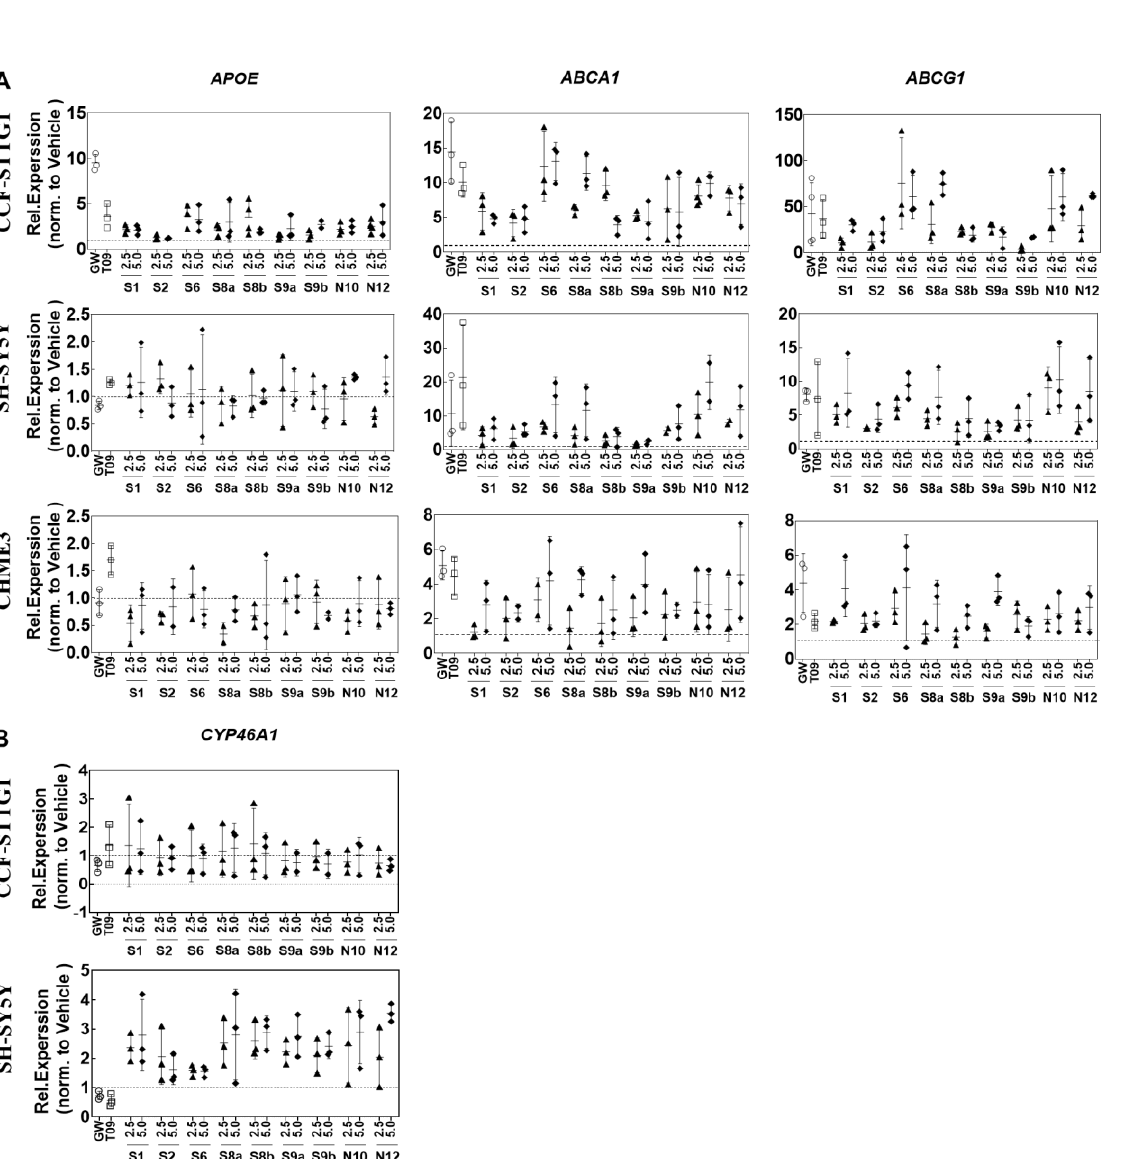
Figure 3. Differential effects of five oxidized sterols on cholesterol turnover genes and CYP46A1 mRNA levels. ( A ) The expression of APOE, ABCA1 and ABCG1 in CCF-STTG1, CHME3 and SH-SY-5Y cells . ( B ) CYP46A1 expression in CCF-STTG1 and SH-SY-5Y cells. Cells were incubated with 2.5 or 5.0 μM of oxidized sterols and 1 μM T0901317 (T09) and 5 μM GW3965 (GW) compound for 24 h. Total RNA was isolated from the cells and analyzed by qPCR as described in Materials and Methods. Gene expression was normalized to mean of the most stable housekeeping genes ( SDHA, B2M, ACTB and HPRT1 ) and expressed as Relative Expression compared to the vehicle control. The values are presented as the means of three experiments ± SD ( n = 3).